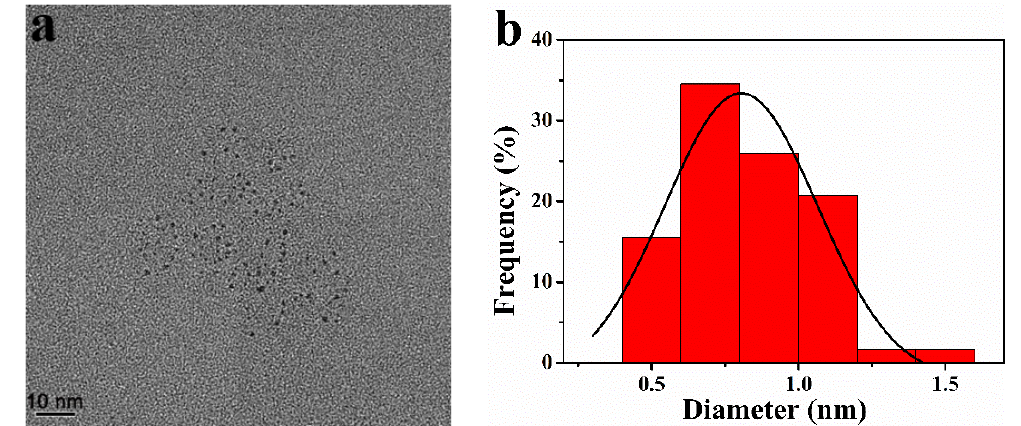
Figure 2. ( a ) HRTEM image and ( b ) size distribution of Pt NCs inside of Pt-BGP